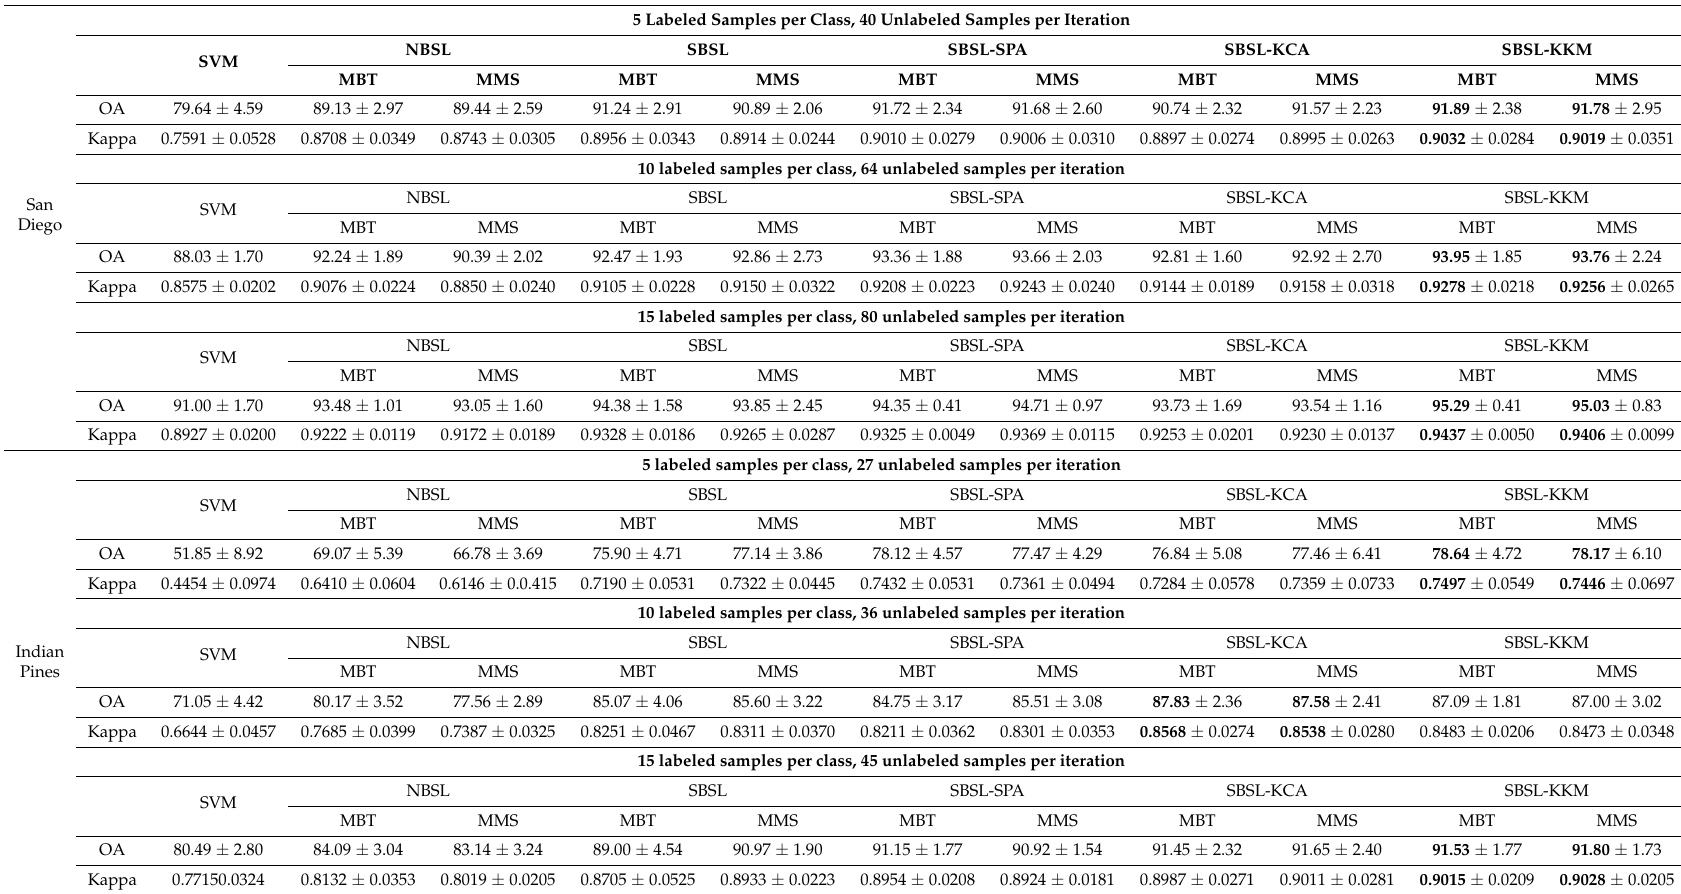
Table 1. Overall accuracies of San Diego and the Indian Pines region data sets